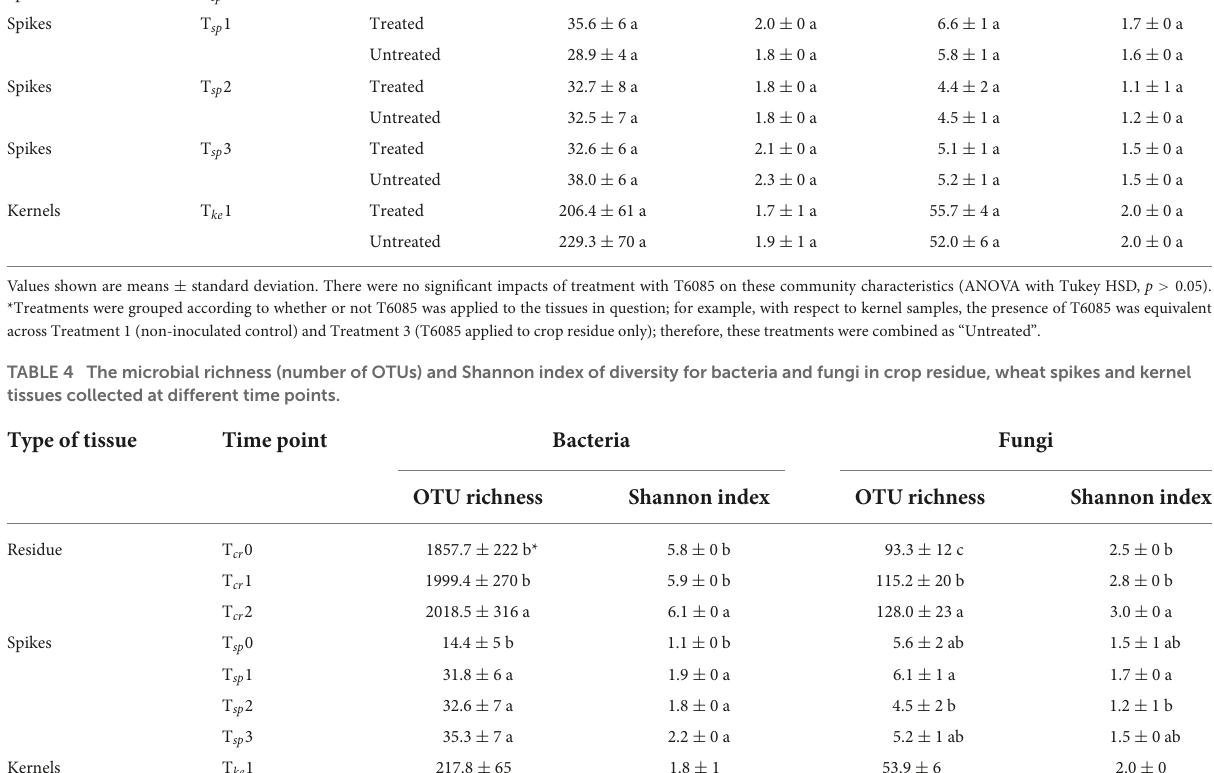
Values shown are means ± standard deviation. There were no significant impacts of treatment with T6085 on these community characteristics (ANOVA with Tukey HSD, p > 0.05). *Treatments were grouped according to whether or not T6085 was applied to the tissues in question; for example, with respect to kernel samples, the presence of T6085 was equivalent